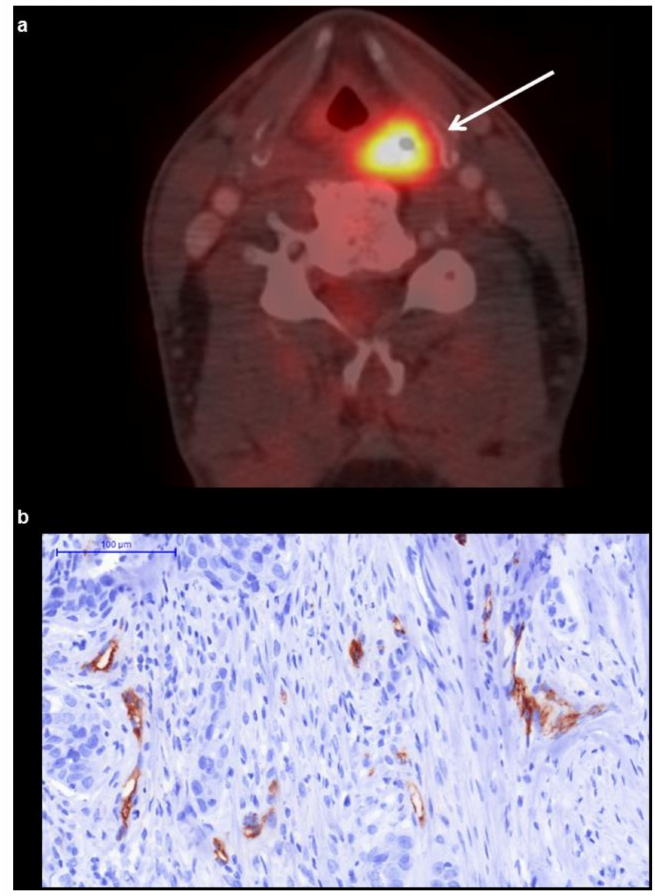
Figure 1. ( a ) 18 F-fluordeoxyglucose ( 18 F-FDG)-PET / CT shows a metabolically active hypopharyngeal